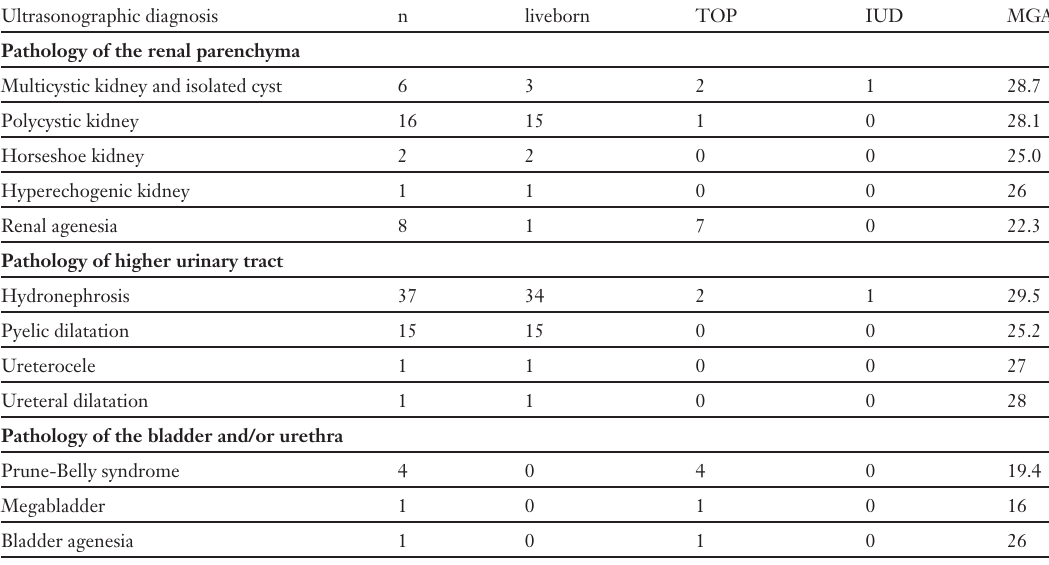
Table 2 Fetal urinary